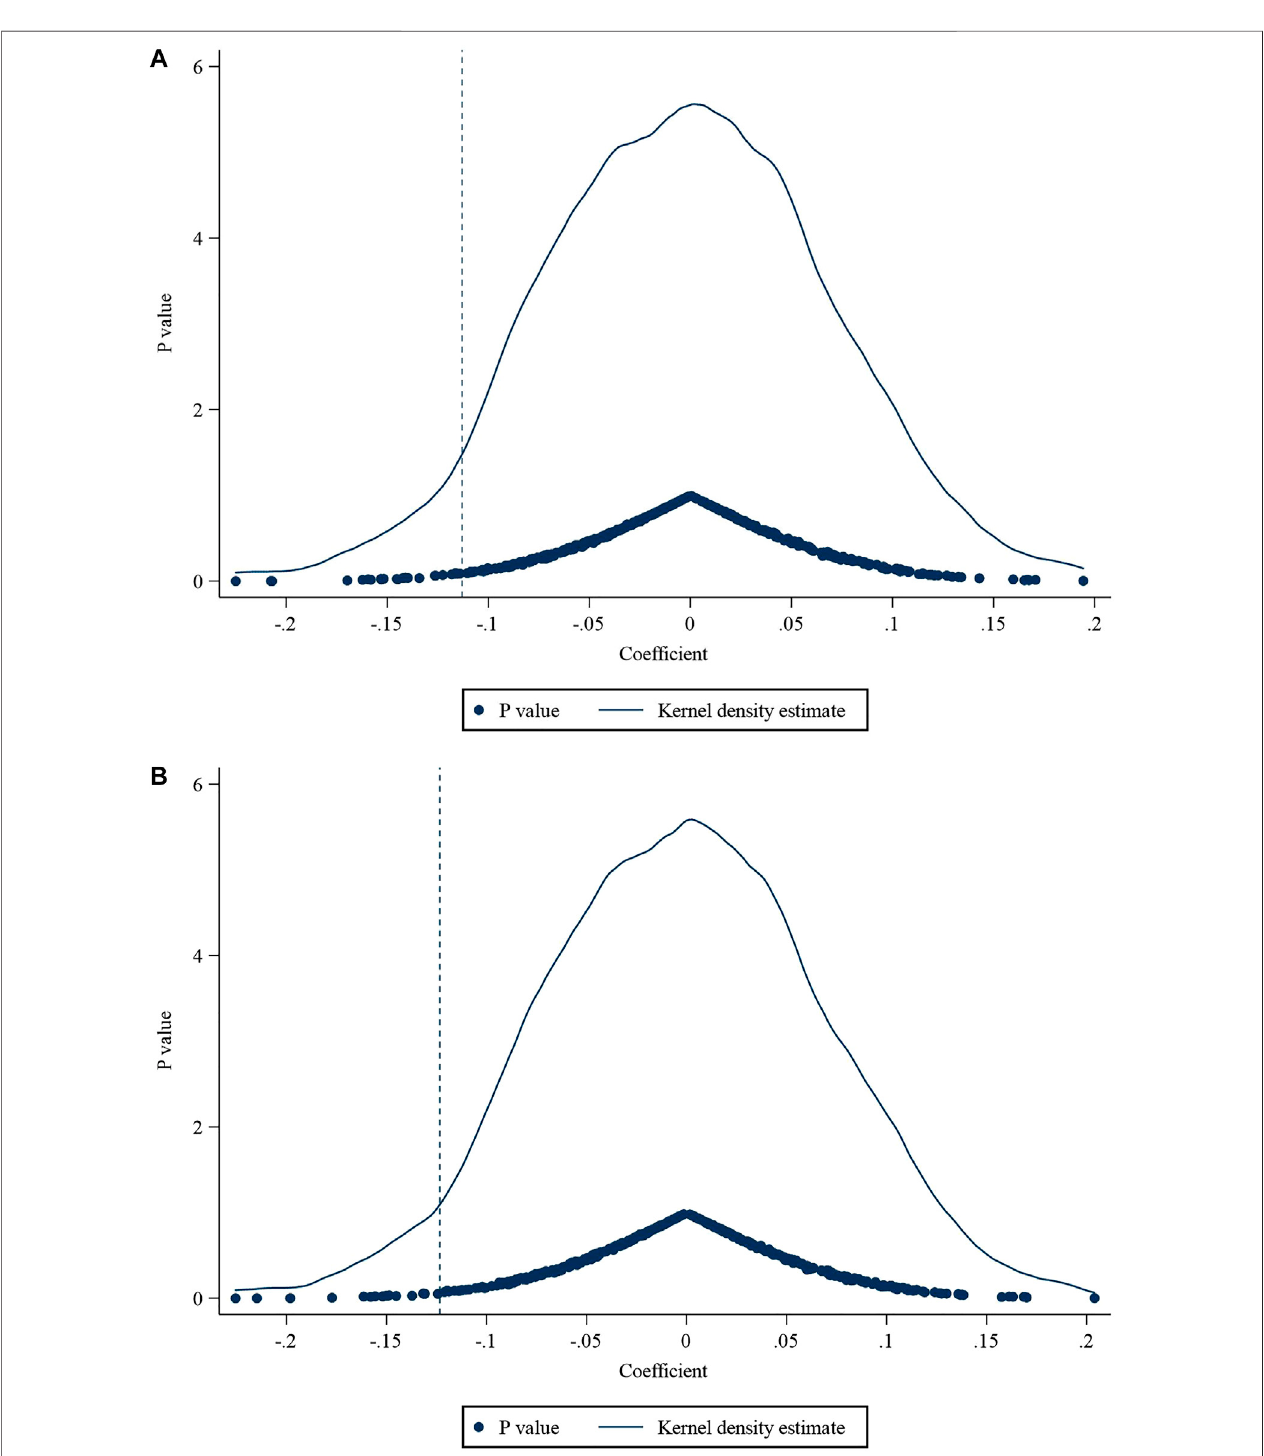
FIGURE 2 | Placebo Tests (A) : Random selections for EID cities (export) (B) : Random selections for EID cities (export per capita).